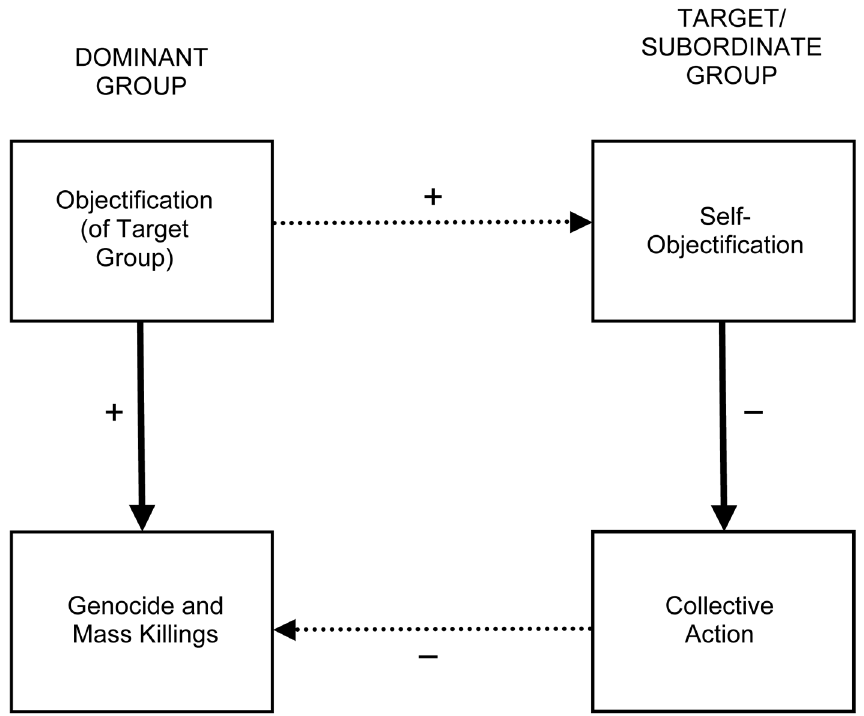
Figure 1. Proposed model linking objectification, self-objectification, and societal